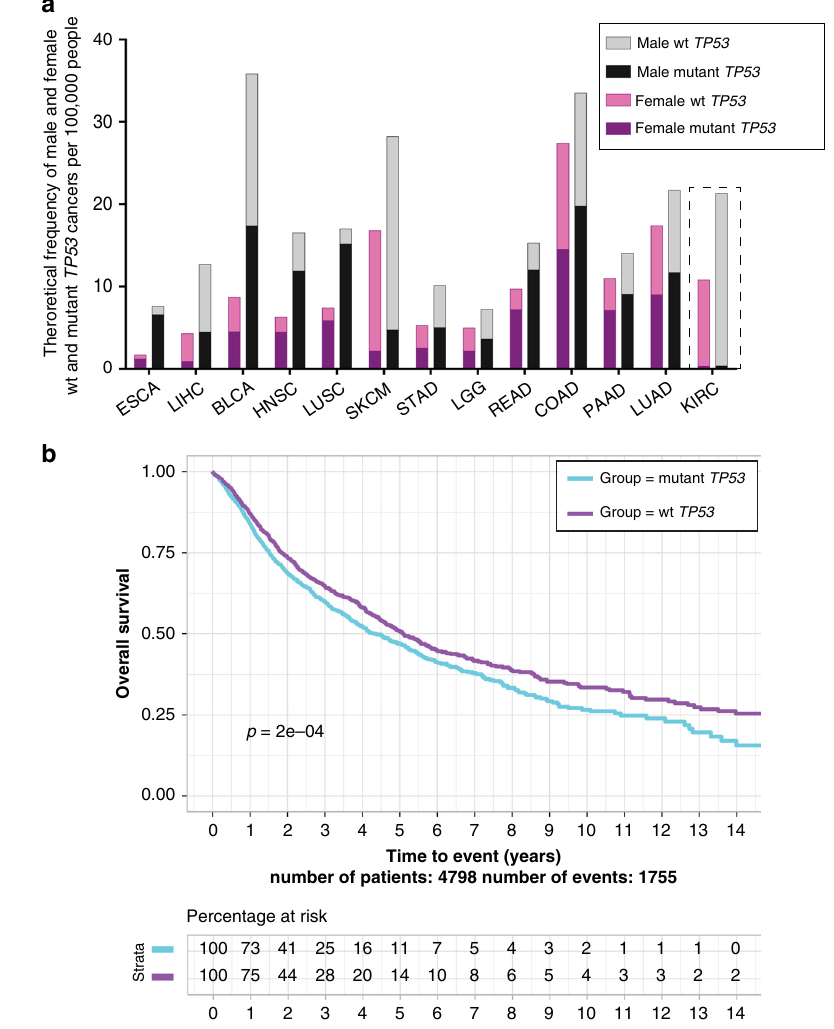
Fig. 1 The frequency of cancer with TP53 mutation is greater for males than females in multiple non-reproductive cancer types with TP53 mutation corresponding to poorest survival. a Predicted TP53 mutation incidence in male and female cancers in the US population as calculated from combined SEER and TCGA data for the13 most abundant non-reproductive cancers: oesophageal carcinoma (ESCA), liver hepatocellular carcinoma (LIHC), bladder urothelial carcinoma (BLCA), head and neck squamous cell carcinoma (HNSC), lung squamous cell carcinoma (LUSC), skin cutaneous melanoma (SKCM), lower grade glioma (LGG), rectum adenocarcinoma (READ), stomach adenocarcinoma (STAD), colon adenocarcinoma (COAD), pancreatic adenocarcinoma (PAAD) and lung adenocarcinoma (LUAD and the exception (demarcated by a dashed box), kidney renal clear cell carcinoma (KIRC). b Overall survival (OS) across 14 years, for patients from the 12 disparity cancers in TCGA is strati fi ed for cancers with wt TP53 (aquamarine) and mutant TP53